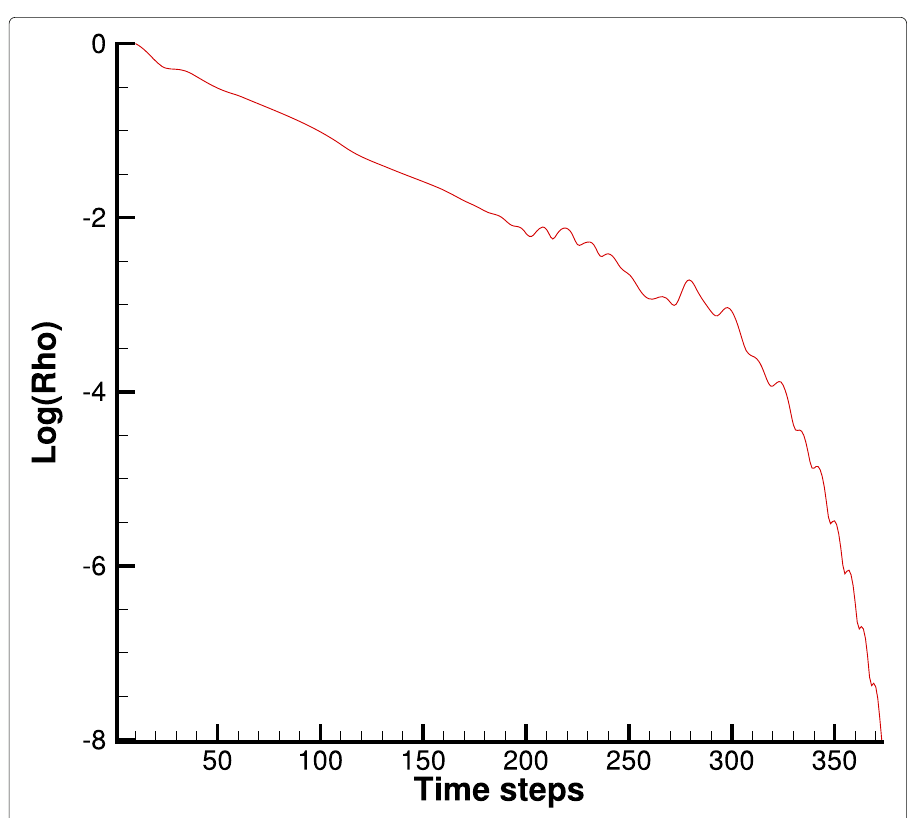
Fig. 8 Residual convergence history of the transonic flow over NACA0012